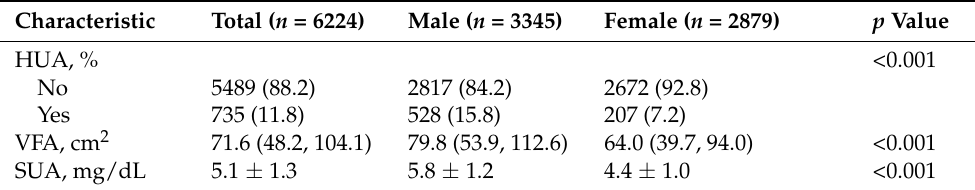
Table 2. Characteristics of the participants according to sex.